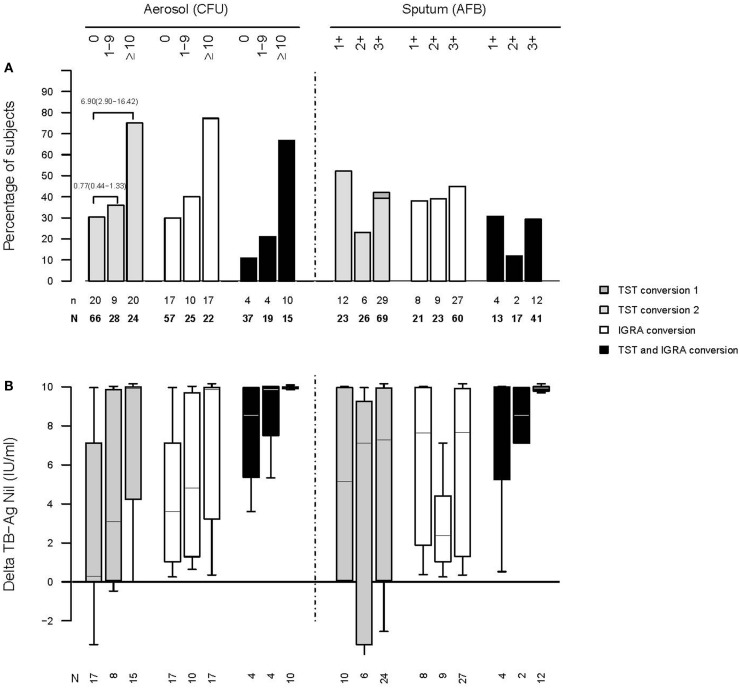
Increasing rates of infection among household contacts of active cases of TB who produced larger cough aerosols (A). Increasing amounts of interferon gamma output in an interferon-gamma release assay among household contacts exposed to active cases of TB who produce larger cough aerosols (B) [from Ref. (68); please see that paper for details regarding numbers of subjects listed].